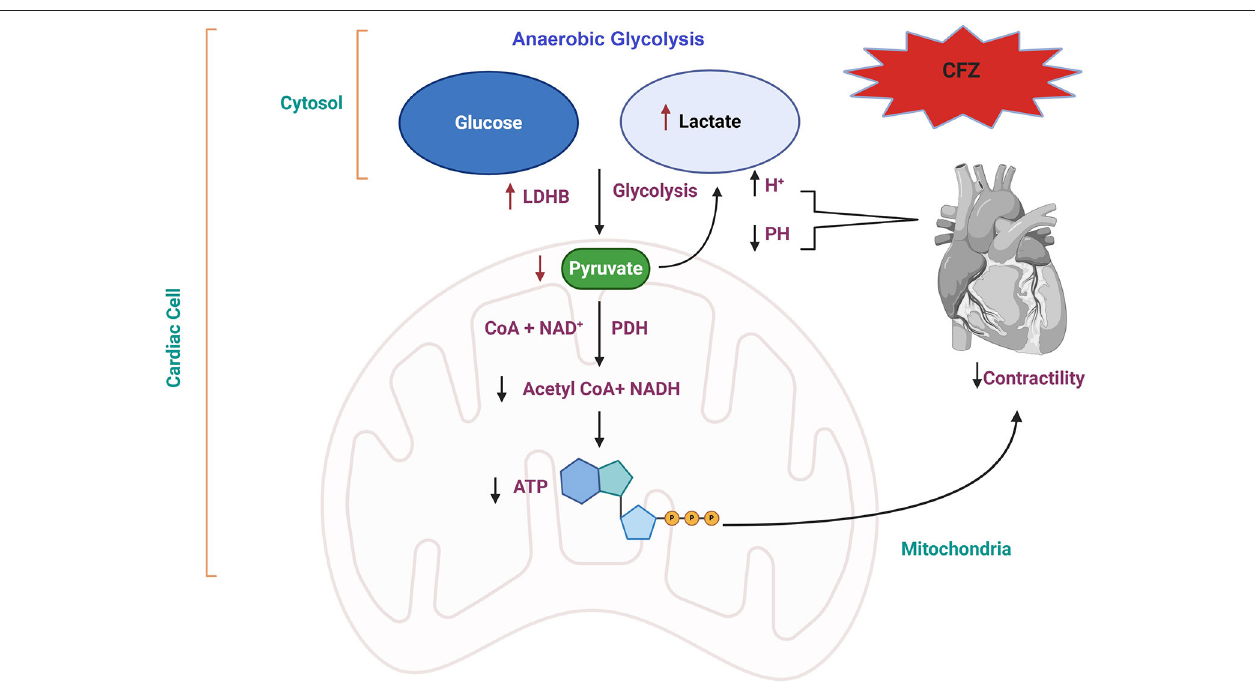
FIGURE 5 | Proposed molecular mechanism of CFZ-CVAEs. Red arrows indicate the changes in this study. CFZ, carfilzomib; LDHB, lactate dehydrogenase B; PDH, pyruvate dehydrogenase; NADH, nicotinamide adenine dinucleotide hydrogen; ATP, adenosine